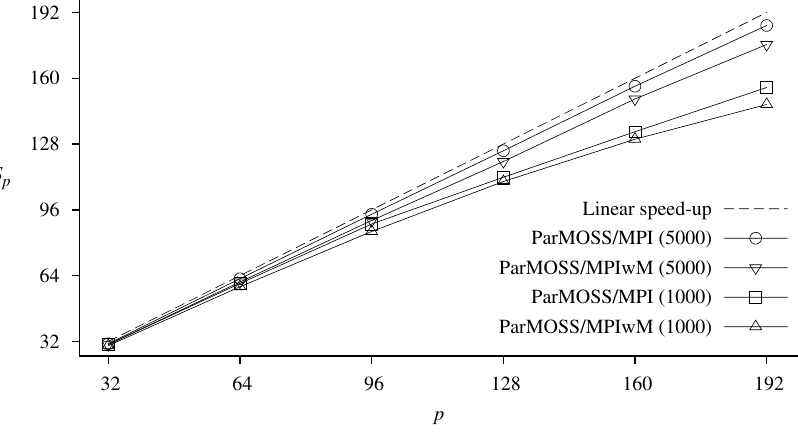
The performance of the proposed distributed-memory parallel algorithms has been investigated using a larger number of processing units – from 32 to 192. The Pareto front of two instances of the CFLP – with 5000 and 1000 demand points – has been approximated by 25000 function evaluations as in previous experiments. The average speed-up of the algorithm versus the number of processing units is presented in Figure